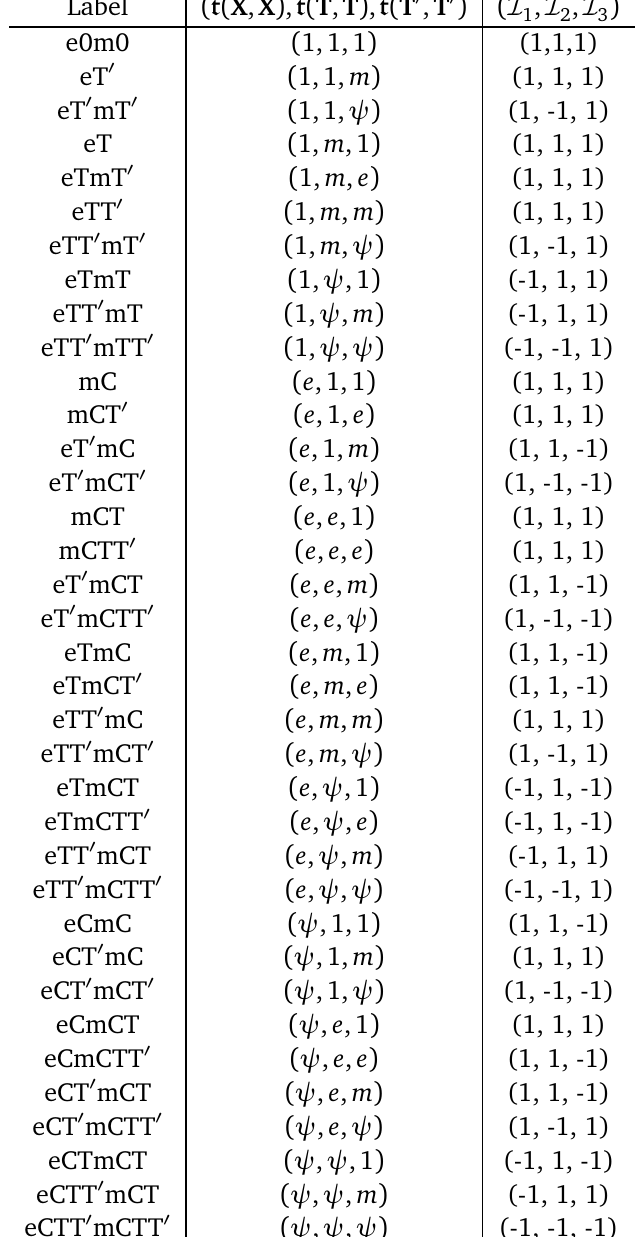
(cid:2) Z T Table 2: Anomalies for Z toric code with Z symmetry, where symmetries do 2 2 2 not permute any particle types. e0m0 refers to the trivial symmetry fractionalization class. If e or m does not appear in the label, then it has trivial symmetry fractional- ization quantum